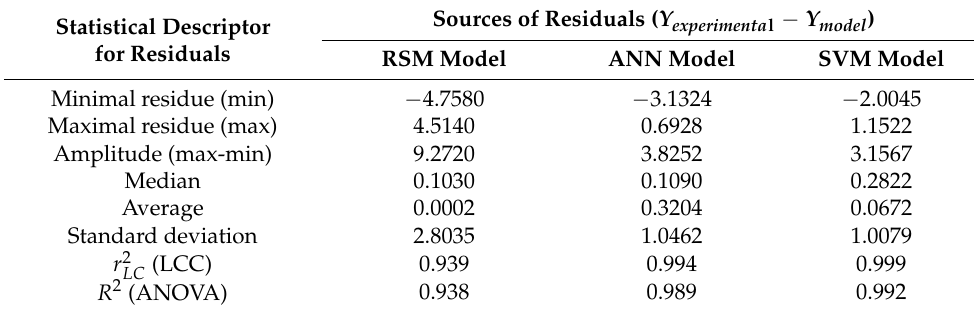
Table 2. Residual analysis and descriptive statistics of residual